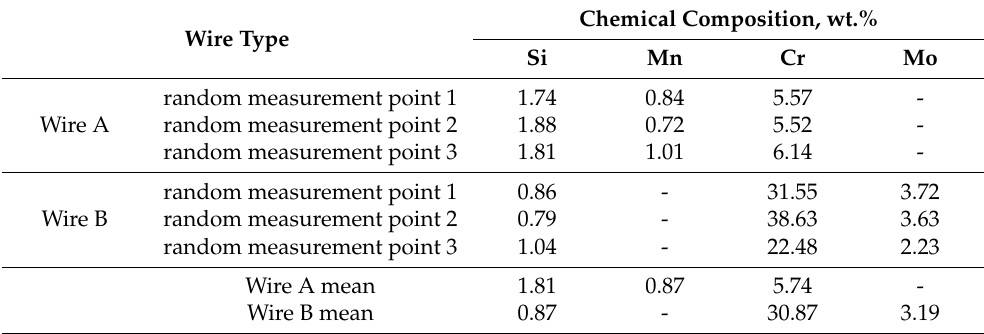
Table 5. The chemical composition of the investigated cored wires (optical emission